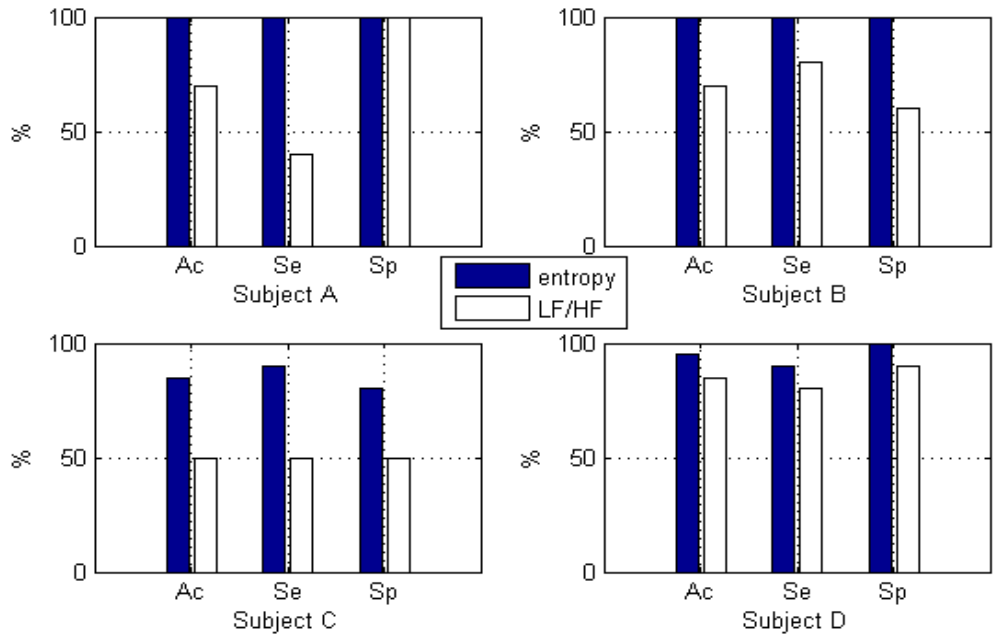
Figure 12. Performance of SVM classifier when using leave-one-out